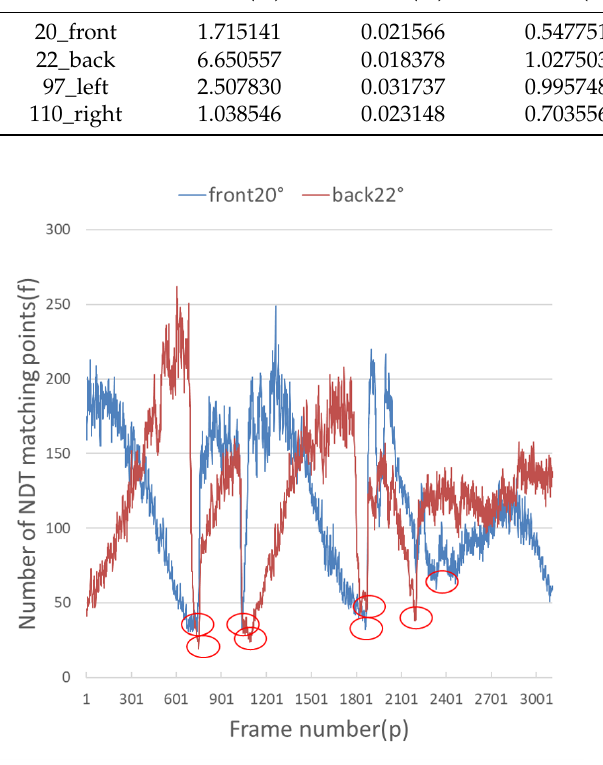
Figure 9. Number of valid points on the front and back during NDT relocation.